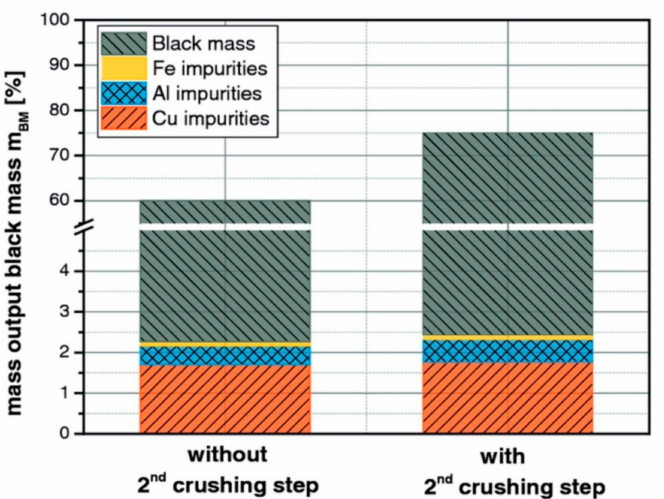
Figure 5. Yield of the black mass and impurities with/without 2nd crushing step [39]. Reprinted from Journal of the Electrochemical Society, Vol. 164, J. Diekmann et al., Ecological Recycling of Lithium- Ion Batteries from Electric Vehicles with Focus on Mechanical Processes, no. 1, pp. A6184–A6191, Copyright (2021), with permission from Journal of the Electrochemical